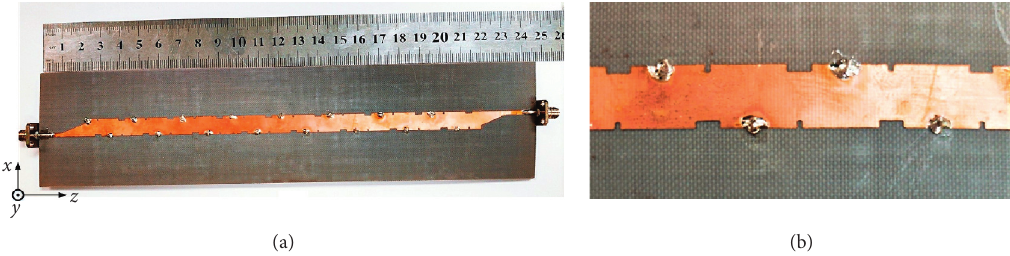
Figure 15: (a) Prototype of the proposed periodic MLWA with double-sided shorting pins. (b) Details of the pins and slots in the proposed antenna.